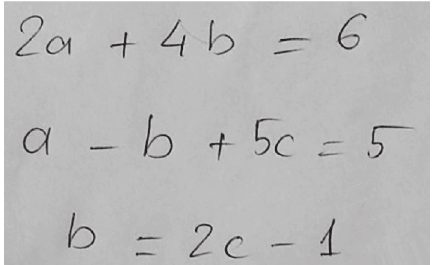
Figure 12: The original image after rotating.